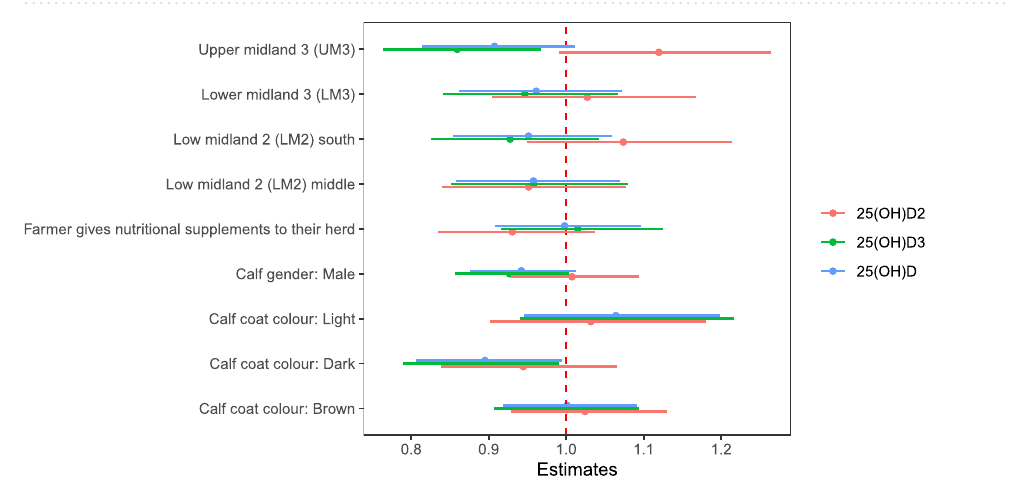
Figure 5. Estimates of effect sizes for the calf level factors affecting serum 25(OH)D concentration. Average model estimates are calculated for variables in the top model set (models with a cumulative Akaike weight ≤ 0.95, Supplementary Table 1 and Supplementary Fig. 2). Error bars represent the 95% confidence intervals. Factors are considered important if their confidence intervals do not span one, as indicated by the dotted vertical